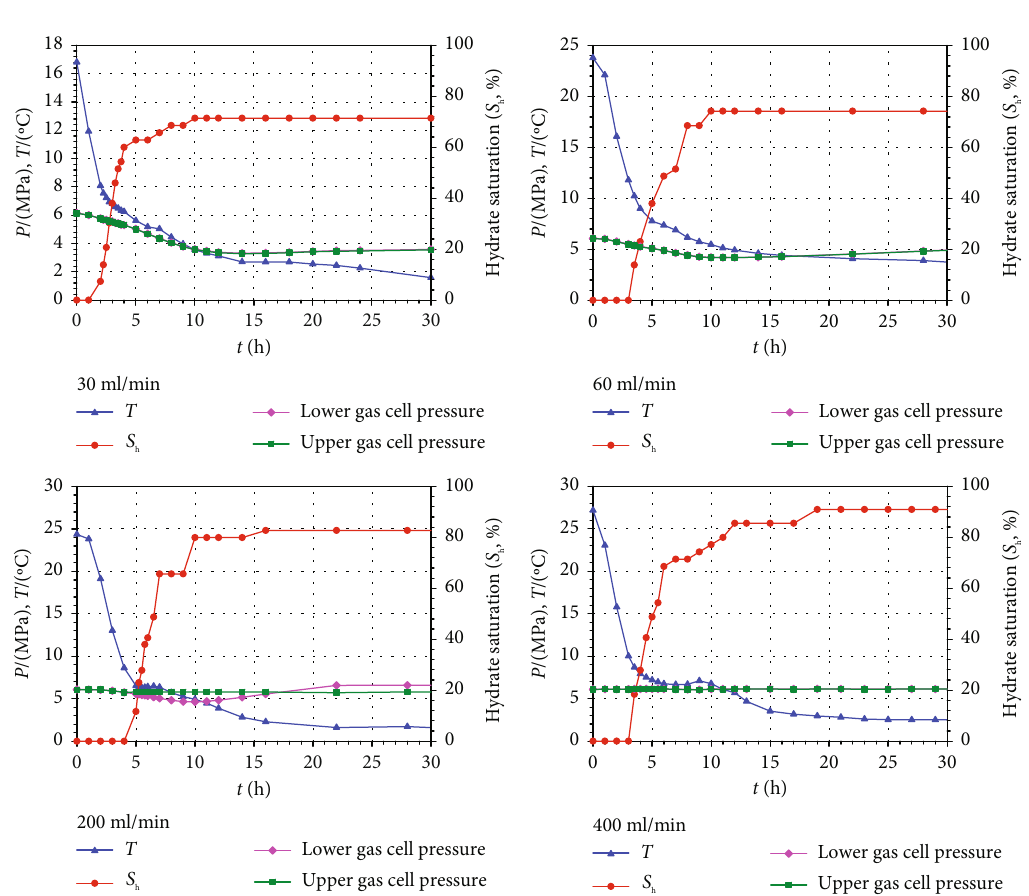
Figure 2: Variation in temperature, pressure and hydrate saturation ( S Figure 2 are in Table S4 in the Supplementary Materials). (Methane fl ow rate: 30ml/min 、 60ml/min 、 200 ml/min 、 400 ml/min).